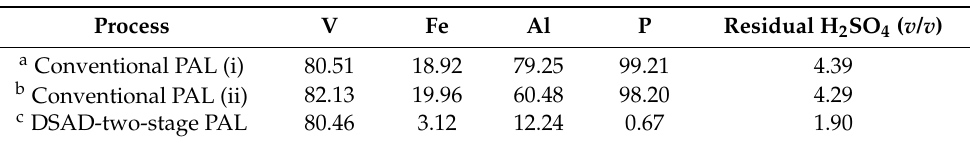
Table 2. Effect of leaching process on the residual H 2 SO 4 concentration and leaching efficiencies of V, Fe, Al and P from the roasted stone coal